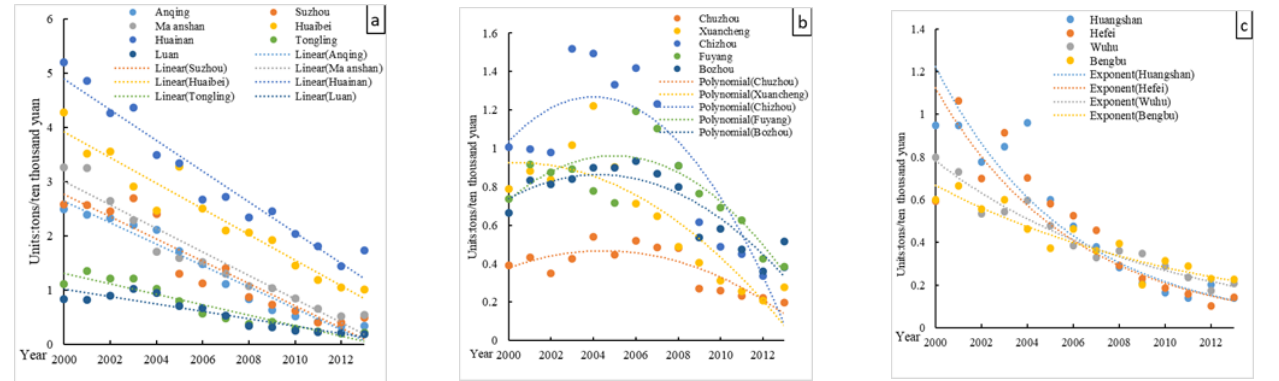
Figure 7. Classification of the 16 prefectural cities of Anhui Province according to their ICEI from 2000 to 2013: ( a ) cities with a stable decrease; ( b ) cities with a first increase followed by a decrease; and ( c ) cities with a “fast-slow” decrease (exponential convergence).